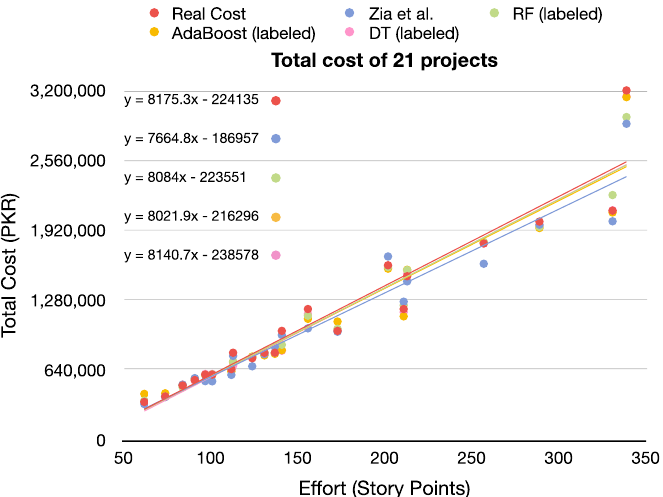
Figure 10. Regression lines for the three machine learning techniques, the real values and the original model (Zia et al. [31]) when predicting total cost.